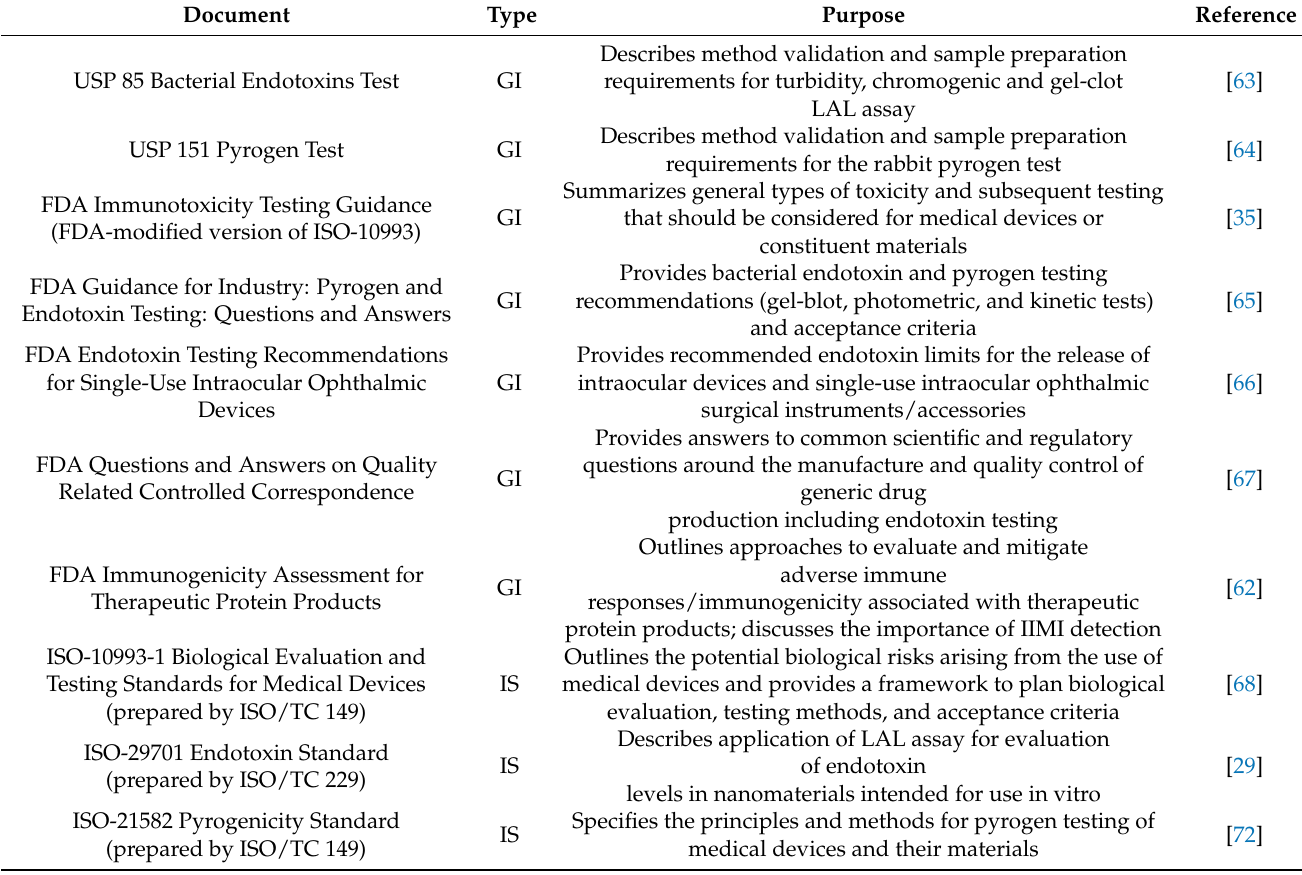
Table 1. Examples of guidance documents and international standards for the measurement of impurities in therapeutic products. International standards (IS) and Guidance for Industry (GI) provided through the U.S. FDA, the U.S. Pharma- copeia (USP), and the International Organization for Standardization (ISO) describe the risks of endotoxin and pyrogen contamination in therapeutic products and outline the assays, protocols, and detection limits which have been standardized and approved for universal application in therapeutic safety and purity